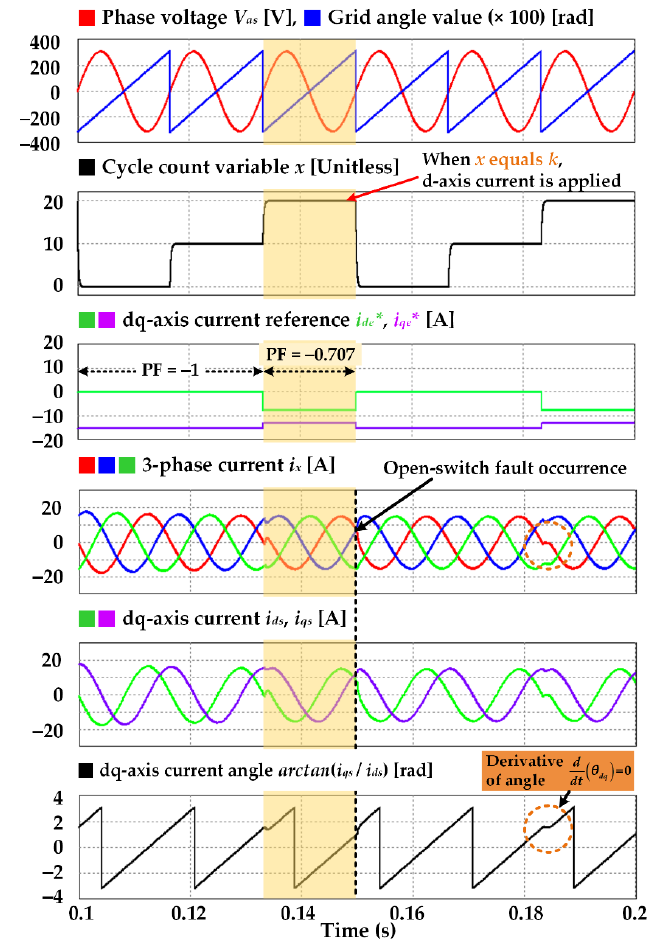
Figure 12. Voltage and current waveforms when intermittent d-axis current injected for IGBT open-switch fault in the HANPC rectifier ( k = 2).